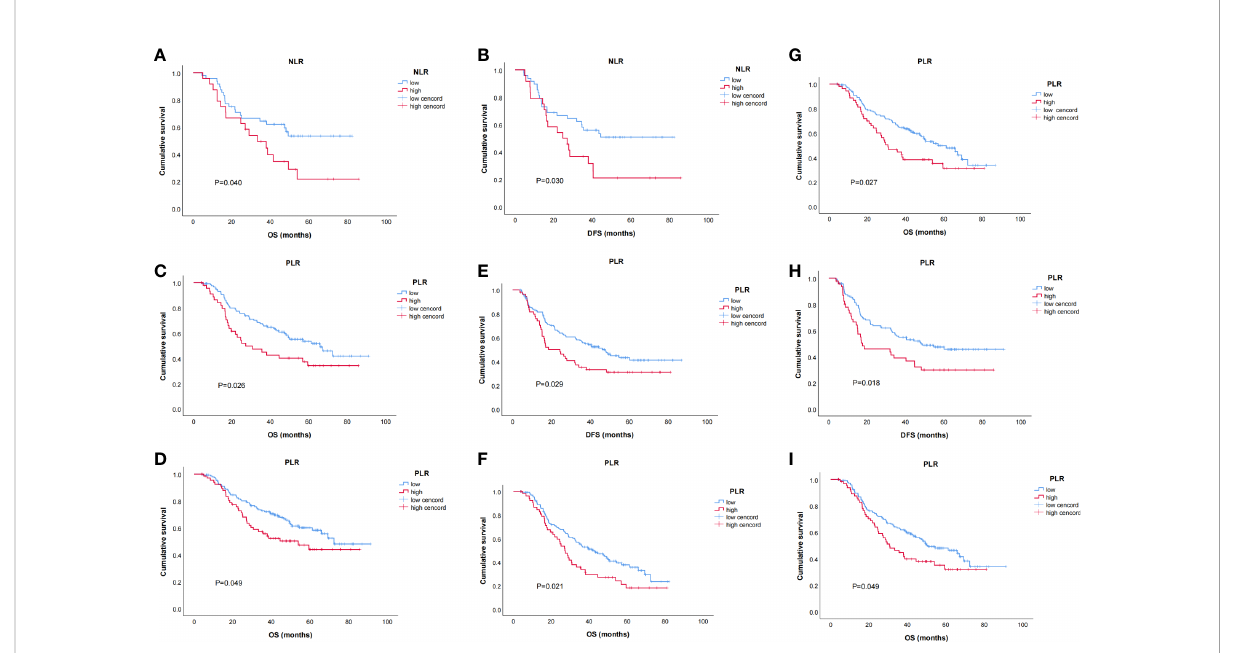
FIGURE 3 Kaplan – Meier survival curves of strati fi ed baseline characteristics. (A) OS for neutrophil-to-lymphocyte ratio (NLR) in female patients ( p = 0.040); (B) disease-free survival (DFS) for NLR in female patients ( p = 0.030); (C) OS for PLR in patients with clinical TNM 3 stage ( p = 0.027); (D) OS for PLR in patients with dissected lymph node counts < 28 ( p = 0.026); (E) DFS for PLR in patients with clinical TNM 3 stage ( p = 0.029); (F) DFS for PLR in patients with dissected lymph node counts < 28 ( p = 0.018); (G) OS for platelet-to-lymphocyte ratio (PLR) in patients age < 65 ( p = 0.049); (H) OS for PLR in patients with positive lymph nodes ( p = 0.021); (I) OS for PLR in patients with moderate or poorly differentiated tumors ( p =